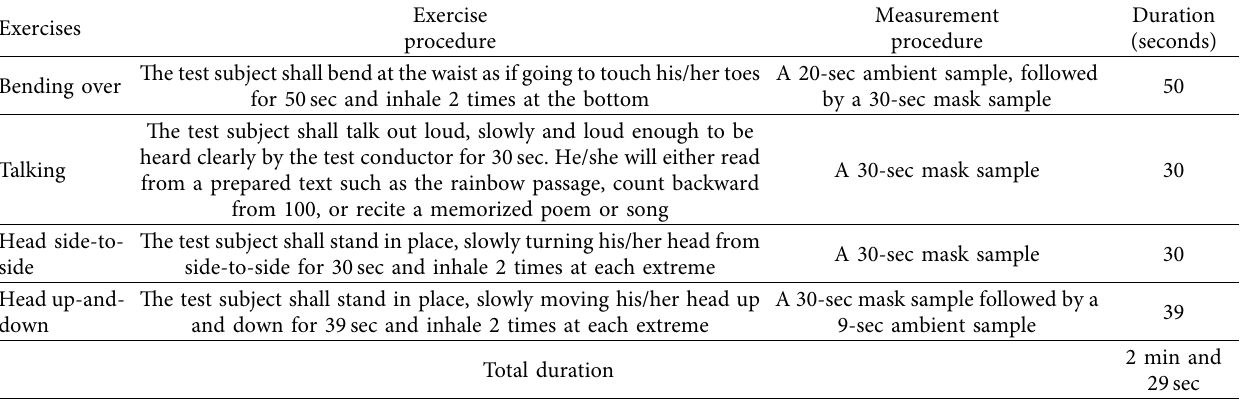
Measurement procedure